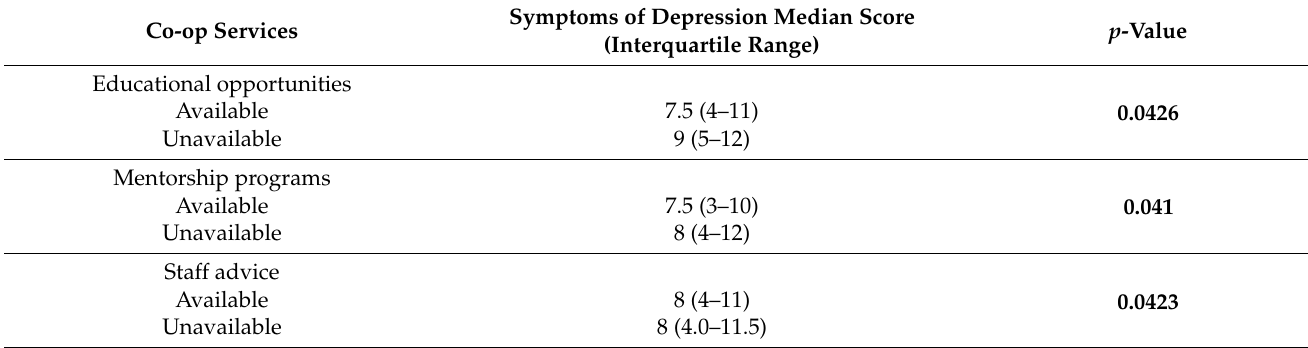
Table 4. Associations between co-op services and symptoms of depression